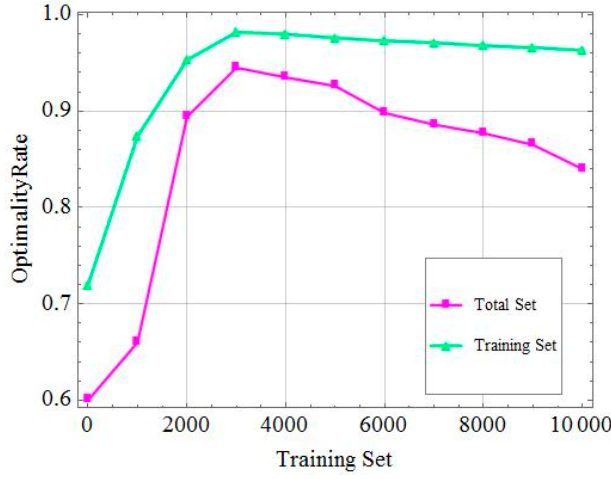
Figure 7. Optimality rate of different training set sizes.